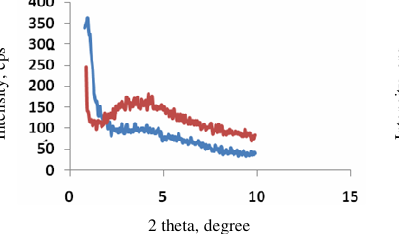
Figure 2. XRD pattern of 1 & 2 at high angles confirming the presence of sodium chloride, the characterized observed peak of NaCl marked by